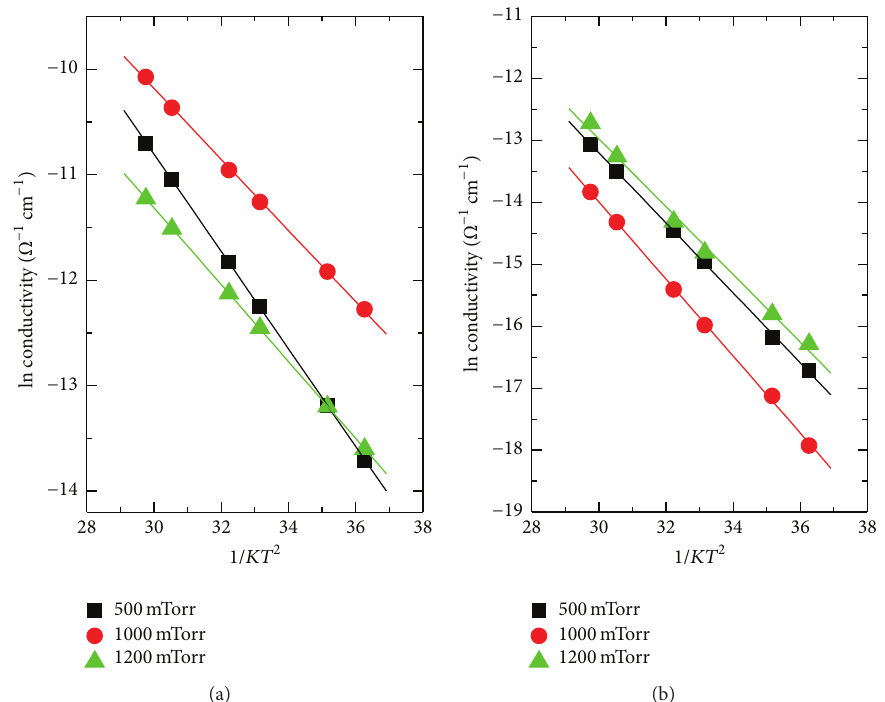
Figure 9: Temperature dependence of conductivity, 𝜎(𝑇) , in two series of pm-Si 𝑥 Ge 𝑦 :H films. (a) Series #1: SiH 4 /GeH 4 = 1 and (b) Series #2: SiH 4 /GeH 4 =